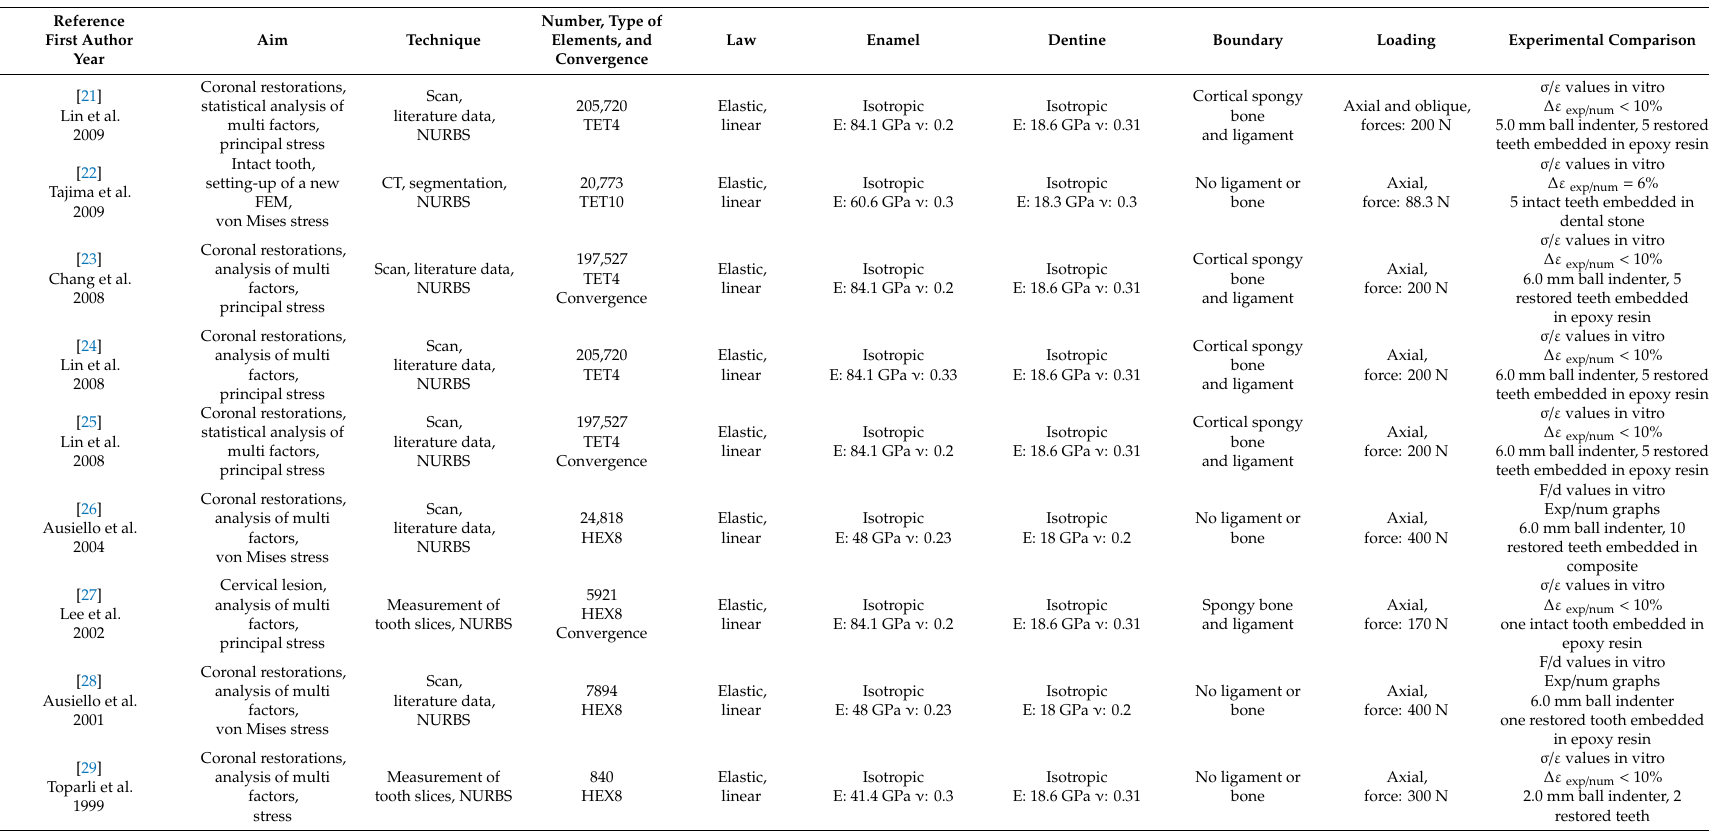
Isotropic E: 84.1 GPa ν : 0.2